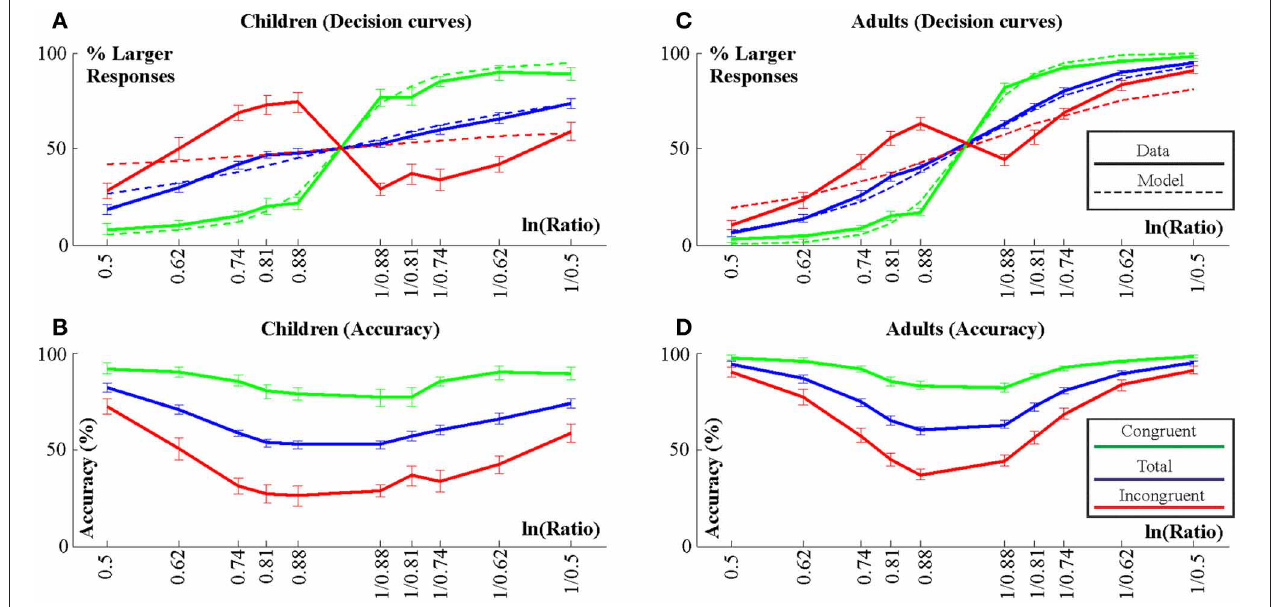
FIGURE 2 | Decision curves (A and C) and accuracy values (B and D) for children (A,B) and adults (C,D). Empirical decision curves are shown by thick lines. These curves show standard errors for each ratio level. Model decision curves are shown by thin dashed lines.